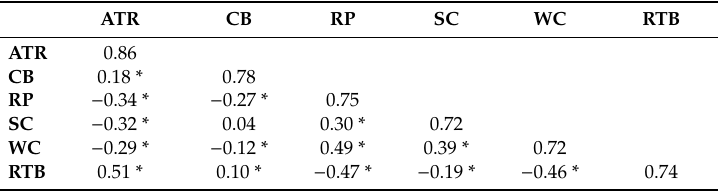
Table 4. Inter-correlations among the constructs.